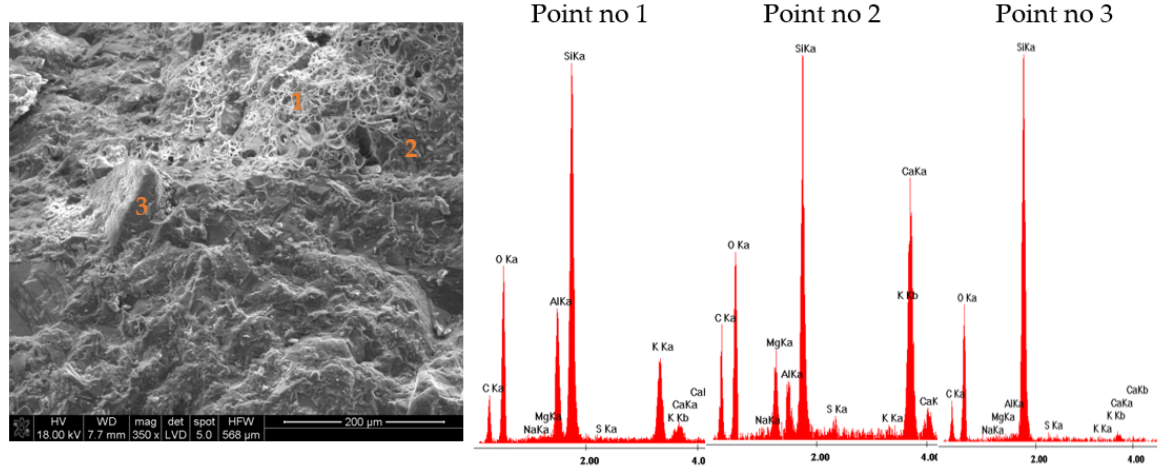
Figure 11. Microstructure of lightweight RPC with 60 vol.% of EP, cured for 28 days in 350 times magnification with EDS analysis in point 1, 2, and 3.